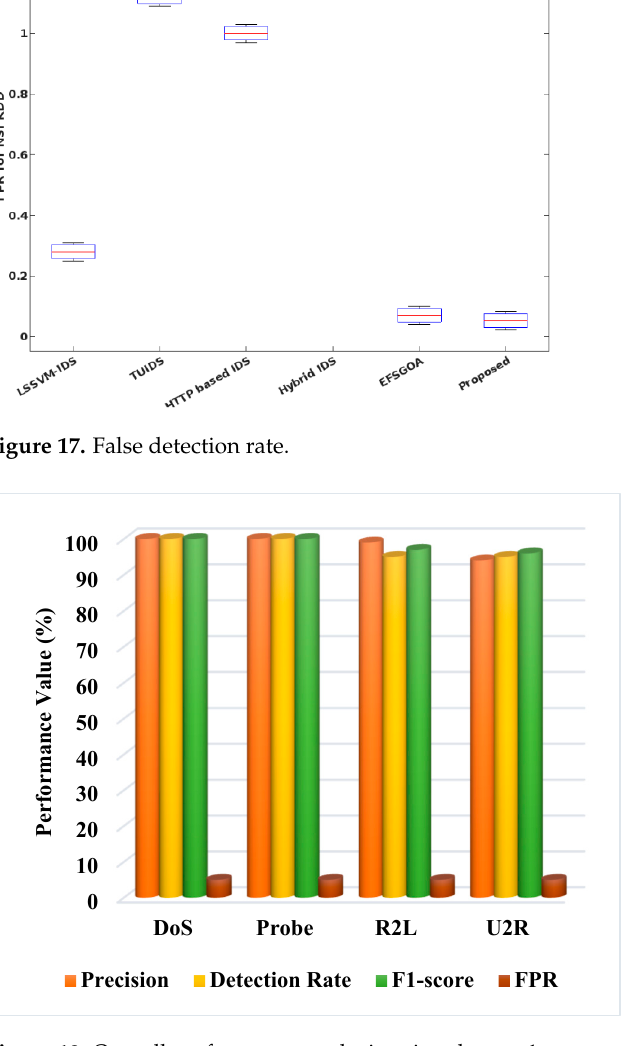
Figure 18. Overall performance analysis using dataset 1. Table 3. Comparative analysis using dataset 3.